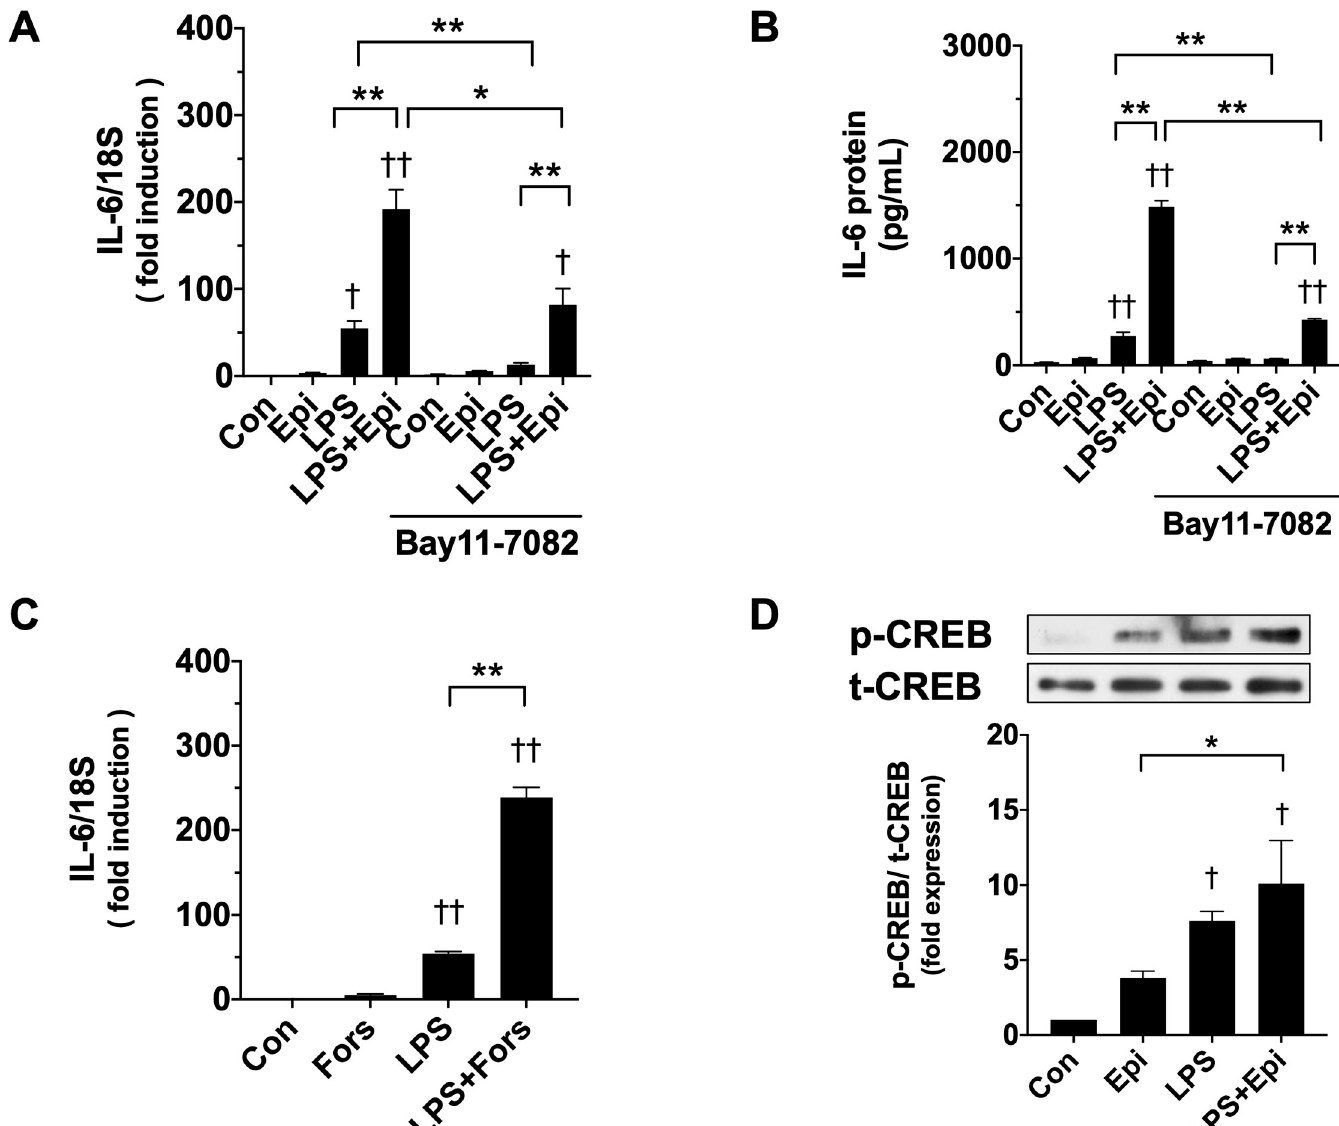
Fig 7. Involvement of NF- κ B activation and cyclic adenosine monophosphate (cAMP) signaling in the IL-6 production induced by LPS and Epi. (A, B) After pretreatment with the NF- κ B inhibitor Bay 11–7082 (10 μ M) or a vehicle for 30 min, C2C12 myotubes were exposed to Epi (1 μ M) and/or LPS (50 ng/ml). IL-6 mRNA was analyzed by qRT-PCR, and its expression levels were normalized to the 18S rRNA expression levels and presented as mean ± SEM (n = 3) of fold induction relative to the value of the control condition (A). The IL-6 concentration in the conditioned media was analyzed with the ELISA assay, and is presented as mean ± SEM (n = 3–4) (B). (C) C2C12 myotubes were treated with Forskolin (10 μ M) and/or LPS (50 ng/ml) for 3 h. IL-6 mRNA expression was analyzed by qRT-PCR, and its expression levels normalized to the 18S rRNA expression levels are presented as mean ± SEM (n = 3) of fold induction relative to the value of the control condition. (D) C2C12 myotubes were exposed to Epi (1 μ M) and/or LPS (50 ng/ml) for 3 h. Whole-cell lysates were analyzed for p-CREB, t-CREB protein expressions with immunoblotting analysis. Representative immunoblots are shown. Expressions of p-CREB proteins were quantified by densitometric analysis, and were normalized to the expression level of t-CREB. Fold induction relative to the value of the control condition is presented as mean ± SEM (n = 3). (†P < 0.05 and ††P < 0.005 compared with control, � P < 0.05 and �� P < 0.005 for comparisons between the indicated